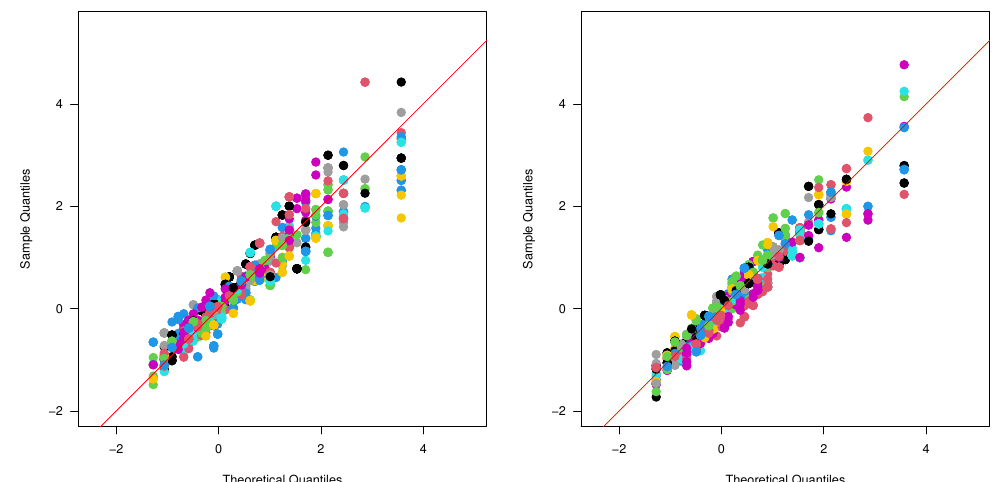
Figure 5. Validation of the BHM-210 ( left ) and BHGCM-210 ( right ) models for all the observatories: Q-Q plots.